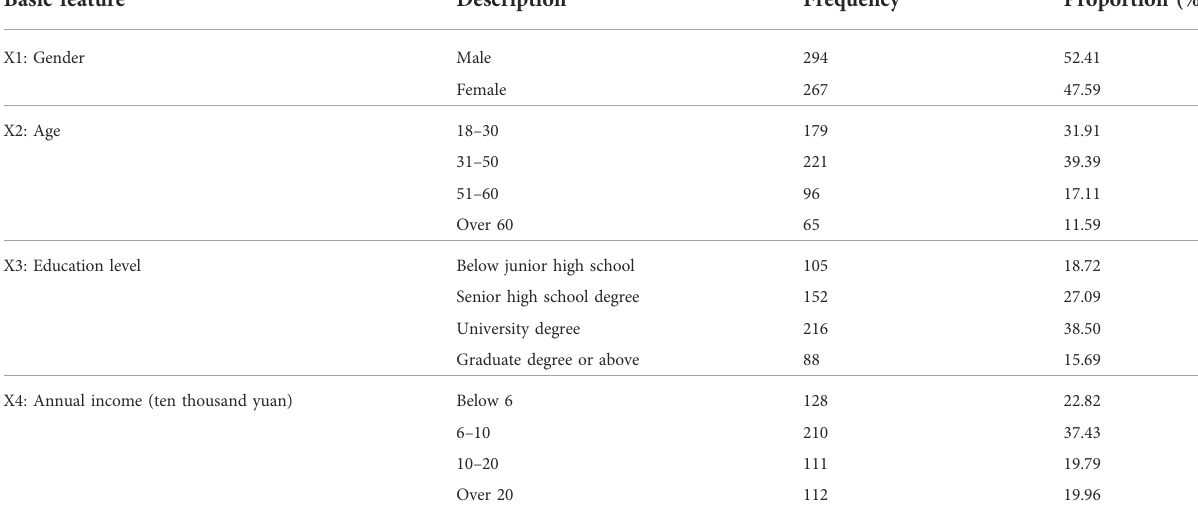
TABLE 1 Respondents ’ personal